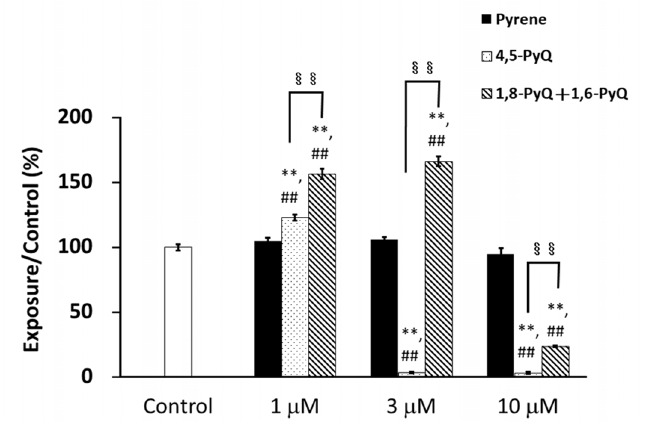
Figure 1. Effects of pyrene and its quinone forms on the viability of human bronchial epithelial cells. Cells were treated with the specified concentrations of pyrene and its quinone forms for 24 h, and their viability was assessed using the WST ‐ 1 assay. The data are represented as the percentage of viability of the control treatment (0 μ mol/L) and are shown as the mean ± standard error of the mean (SEM) from four individual cultures. ** p < 0.01 vs. control, ## p < 0.01 vs. pyrene at the same concentration, §§ p < 0.01 vs. each other.